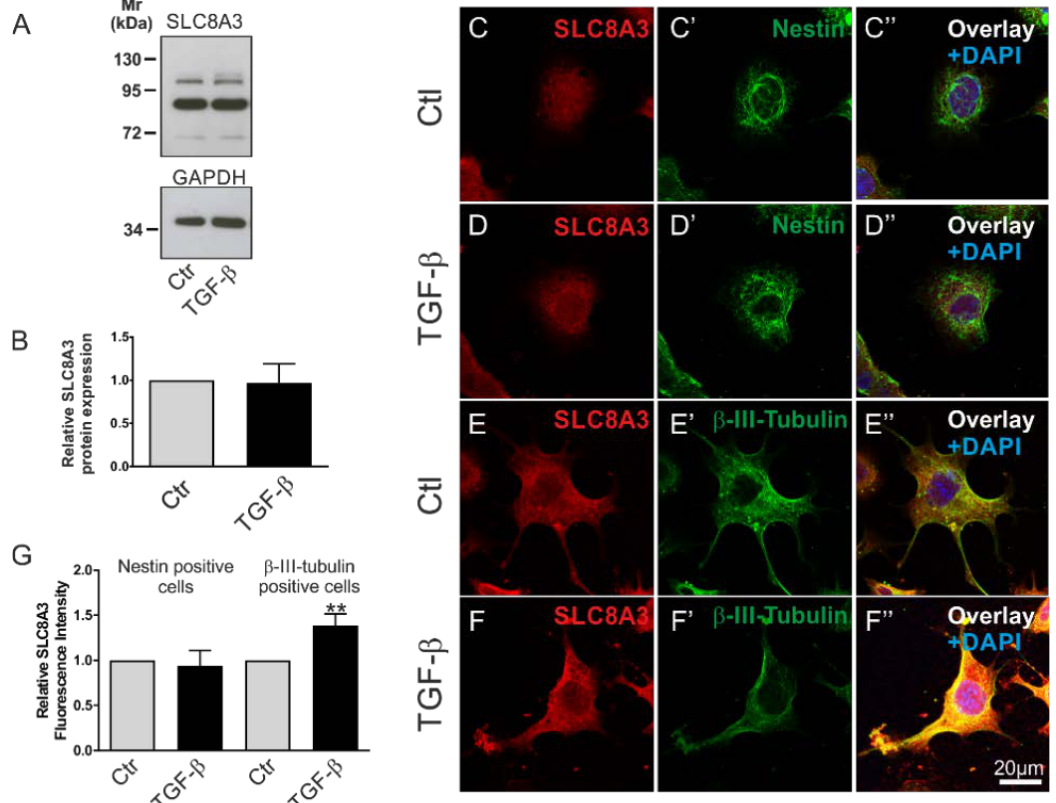
Figure 3. Differential regulation of SLC8A3 in Nestin-positive cells and neurons by TGF- β . ( A ) Protein abundance of SLC8A3 by immunoblotting in control MN9D cells in the presence of exogenous recombinant TGF- β (2 ng/mL), 30 µg protein was loaded per lane. ( B ) Quantification, not significant after densitometric analysis of the signal ratio SLC8A3:GAPDH and two-tailed unpaired Student’s t -test, n = 3. The value of control (ctl) was set to 1. ( C – F’’ ): Confocal double immunofluorescence for SLC8A3 (red) with the stem cell marker Nestin (green; C’ , D’ ) or the neuronal marker β -III tubulin (green; E’ , F’ ) in MN9D cells in the presence ( D , F ) or absence ( C , E ) of TGF- β. ( G ) Quantification of SLC8A3 immunofluorescence intensity in Nestin-positive cells and β -III-tubulin-positive cells in controls and following TGF- β treatment. ** p < 0.01, using two-tailed unpaired Student’s t -test, 30–100 cells/experimental group from 3 to 7 independent experiments. The value of control (ctl) was set to 1.